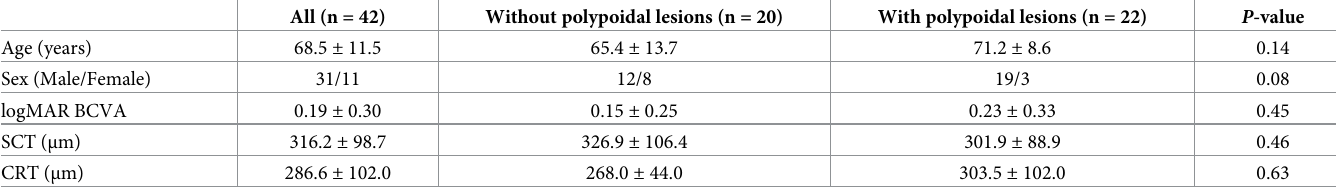
Table 1. Clinical characteristics of patients at